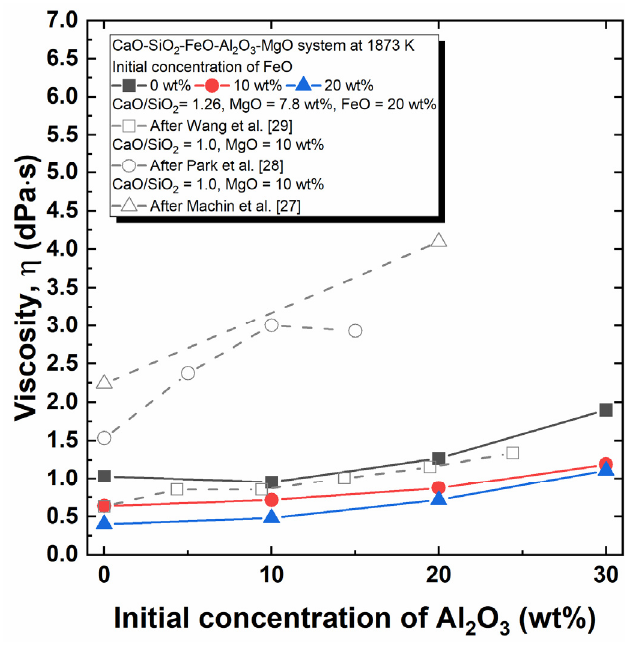
Figure 4. Effect of Al 2 O 3 on the viscosity of CaO–SiO 2 –FeO–Al 2 O 3 –MgO slag system at 1873 K with varying FeO concentrations.